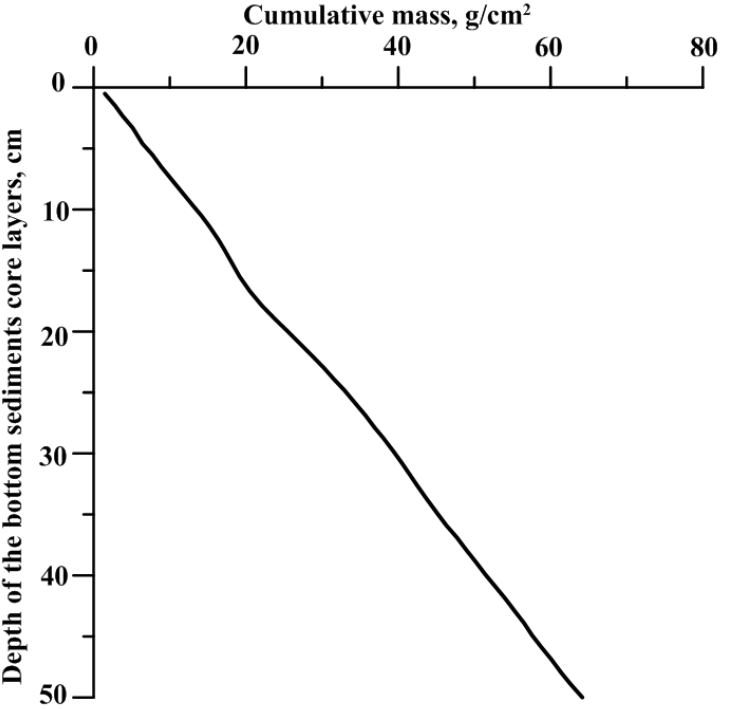
Figure 2. Graph of the cumulative mass of core layers of bottom sediments from Aktashskoye Lake (2017).